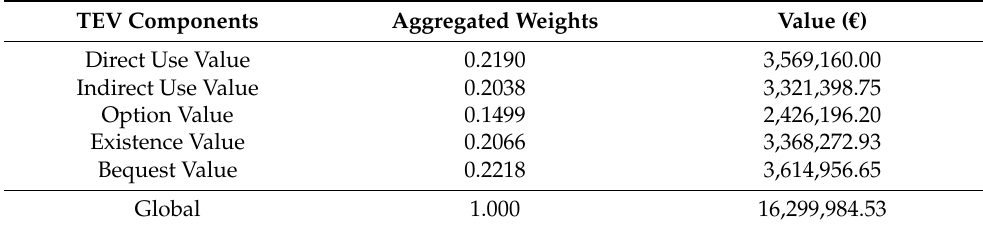
Table 2. Partial and total values obtained from AMUVAN